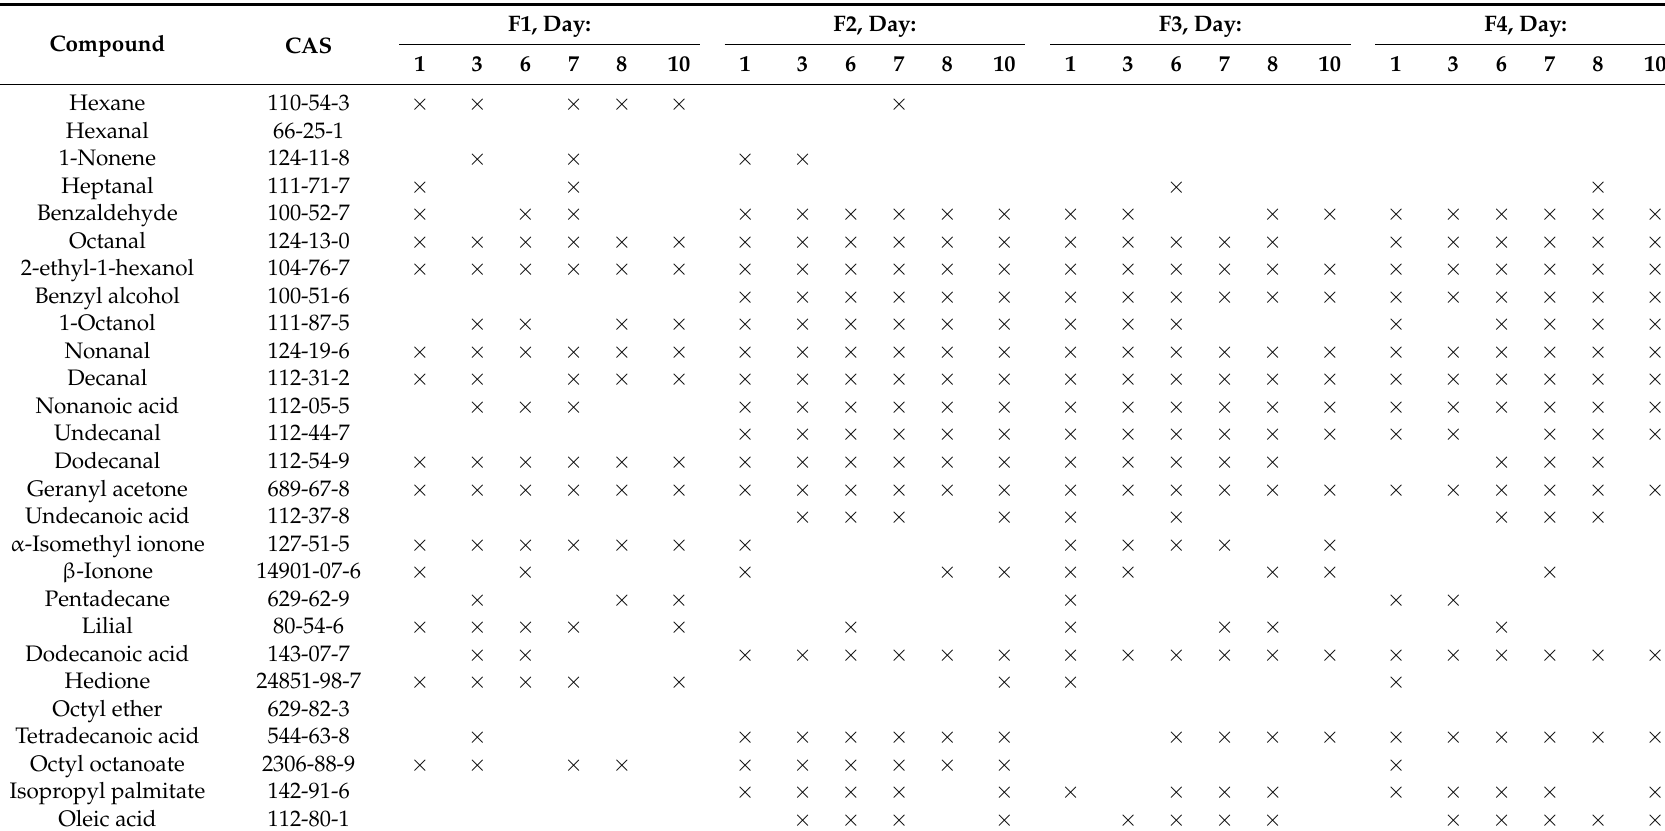
Table 1. Compounds identified in the skin headspace of human participants after 15 min headspace sample collection by solid-phase microextraction (SPME) followed by thermal desorption to gas chromatography-mass spectrometry (GC–MS), in order of increasing retention time. ( × indicates the presence of a compound in a